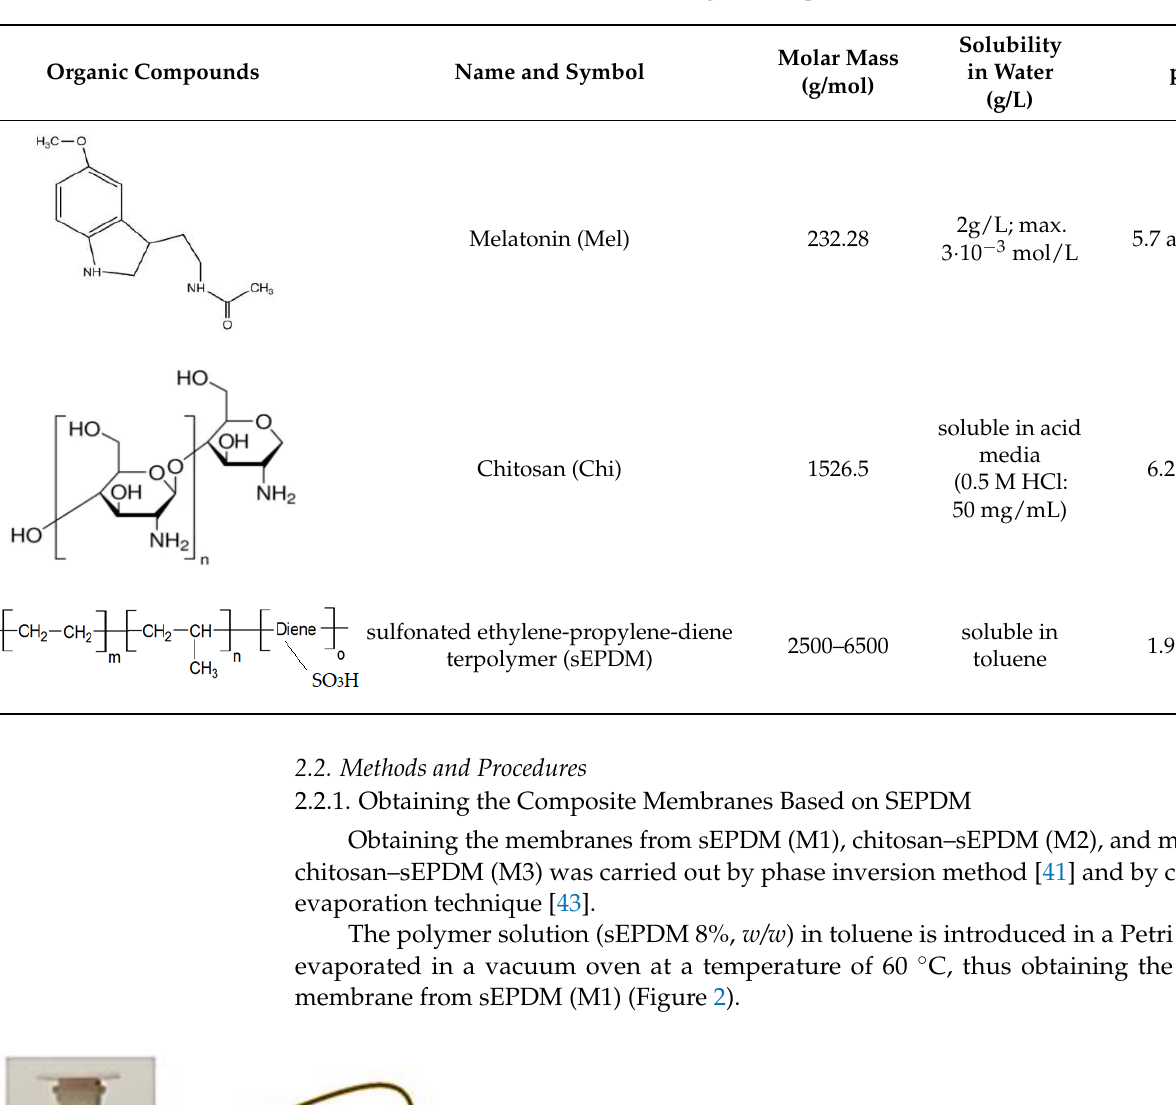
Table 1. The characteristics of the used organic compounds.